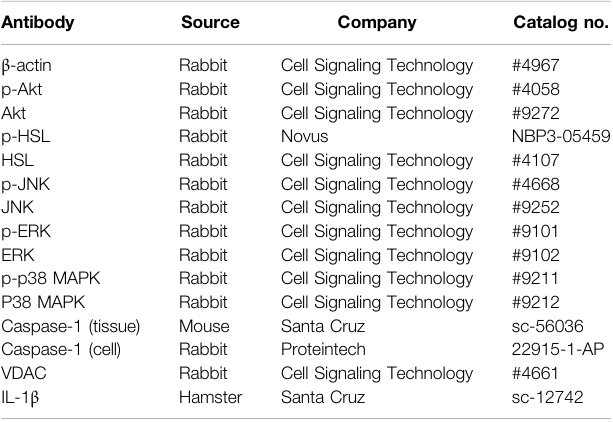
TABLE 2 | Antibodies for